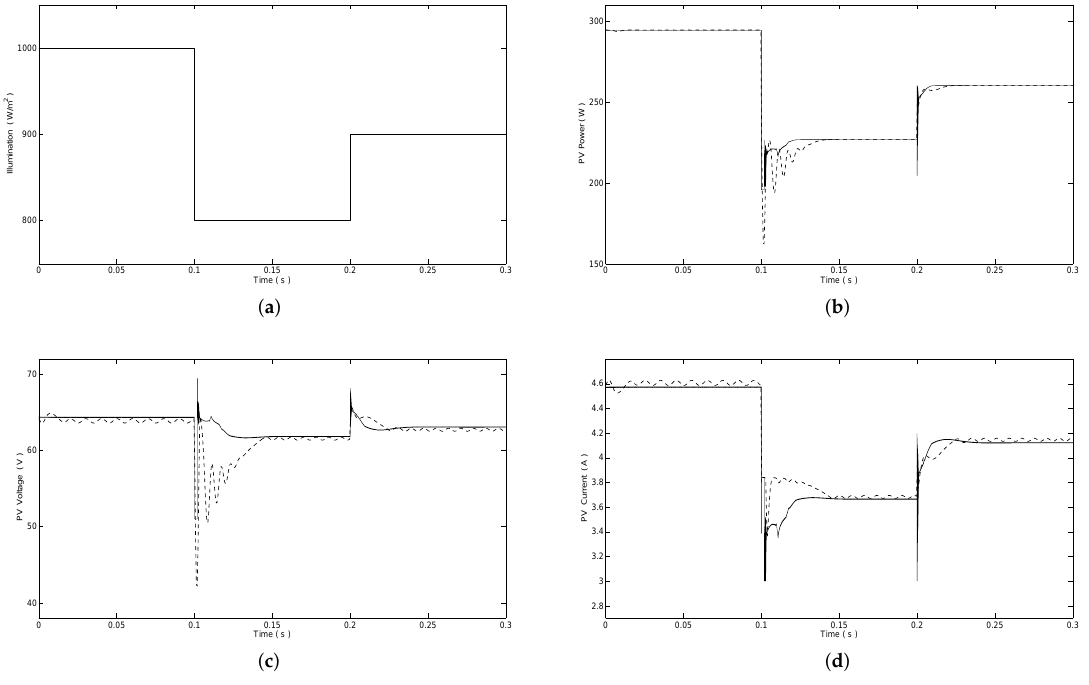
Figure 7. ( a ) The illumination variation; ( b ) corresponding output power; ( c ) output voltage; and ( d ) output current of PV module (proposed MPPT method ( ), traditional P&O algorithm ( −−